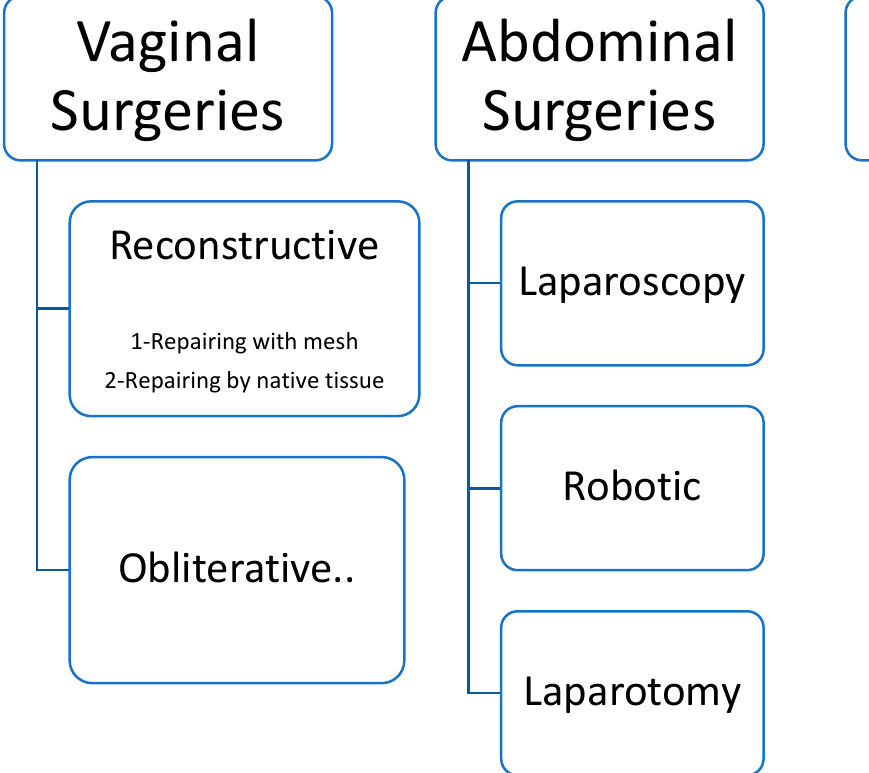
Figure 2. Categorization of the included studies.